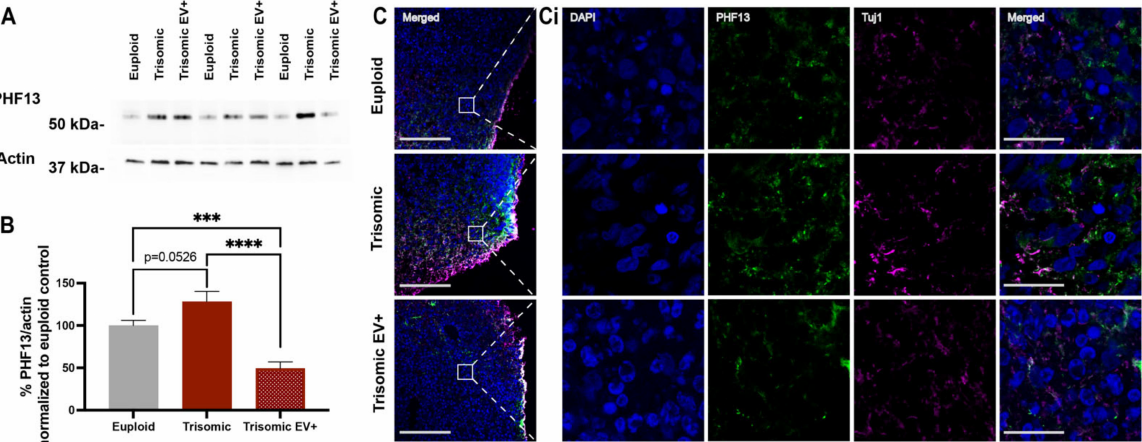
Figure 7. Measurements of PHF13 levels in EV-treated CS. ( A ) Representative Western blot image of tau phosphorylation visualized with PHF13 antibody in whole homogenates of euploid, trisomic, and EV-treated trisomic CS. ( B ) Bar graph of densitometric analysis of the content of phosphorylated tau quantified as a ratio of PHF13 intensity over actin intensity in CS and normalized to the euploid control that was calculated as 100% for each independent experiment; euploid n = 12; trisomic n = 12; trisomic EV+ n = 5 samples per group generated from 4–5 CS combined together per sample. These graphs display results from three independent experiments. Statistical analyses were performed via unpaired t -test with Welch’s correction comparing all three groups to each other. Results are shown as mean ± SE. *** p < 0.001 **** p < 0.0001. ( C , Ci ) Low magnification merged channel images. White boxes represent high magnification insets seen in ( Ci ) showing single and merged channels of confocal images with IHC labeling of PHF13 (green), Tuj1 (magenta), and DAPI in euploid and trisomic untreated and EV-treated CS. Low magnification scale bar = 100 µ m. High magnification inset scale bar = 20 µ